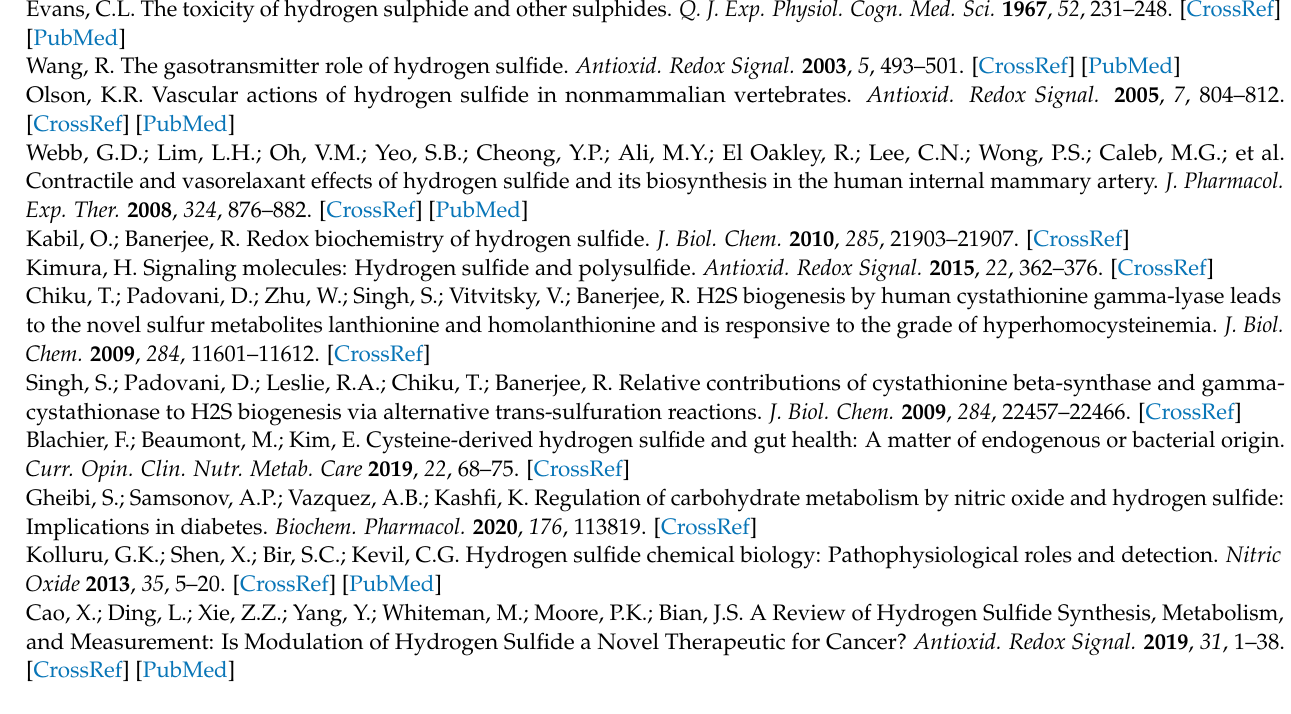
Figure A3. Expression levels of cystathionine- γ -lyase (CSE), 3-mercapto-sulfurtransferase (3-MST), ethylmalonic encephalopathy 1 protein (ETHE1), Sulfide:quinone oxidoreductase (SQOR) and thiosulfate sulfurtransferase (TST) of biopsies from the ascending colon compared to the histologic severity score (HSS) of each sample, separated into Crohn’s disease, ulcerative colitis (UC) and controls (C).